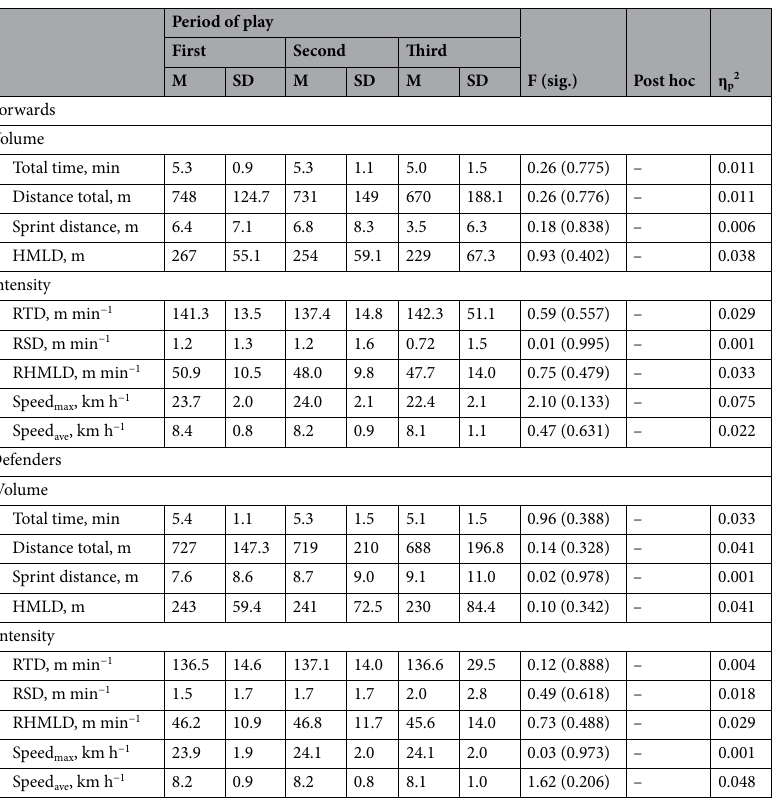
Table 5. Means (M) and standard deviations (SD) for indicators of volume and intensity (per unit playing time) of effort among forwards (n = 33) and defenders (n = 43) by period of play during U16 Hockey5s matches, and results of the linear mixed model and estimated effect sizes (η p 2 ). HMLD, high metabolic load distance; RTD, relative total distance; RSD, relative sprint distance; RHMLD, high relative metabolic load